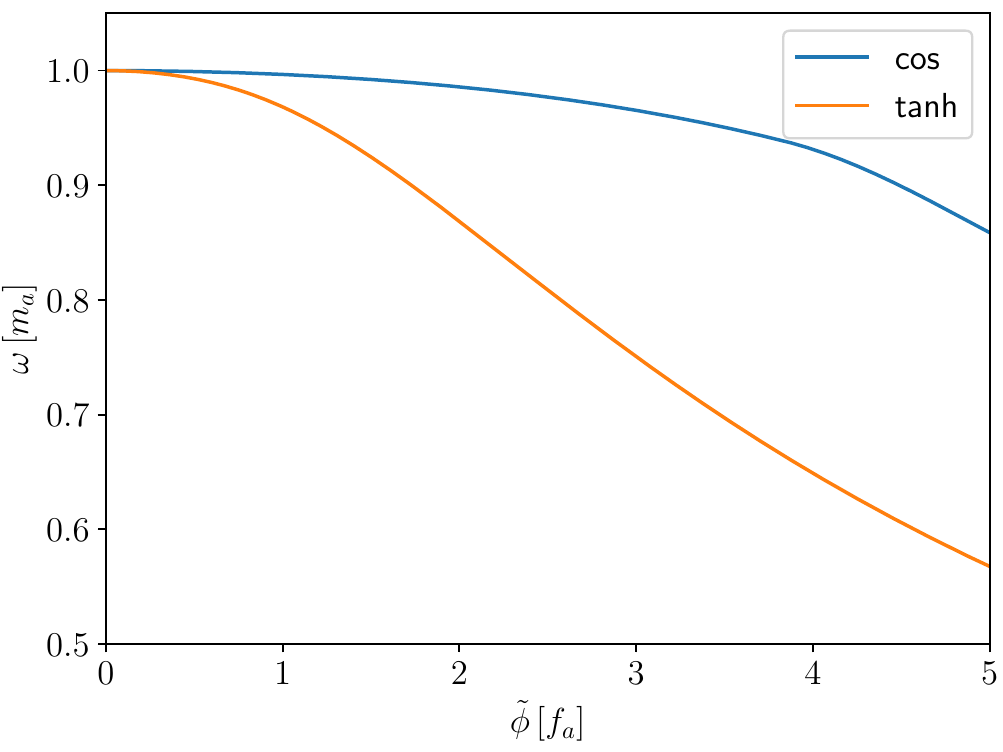
Figure 1 . Clump frequency ω as a function of the central amplitude ˜ φ for the cos- and tanh-